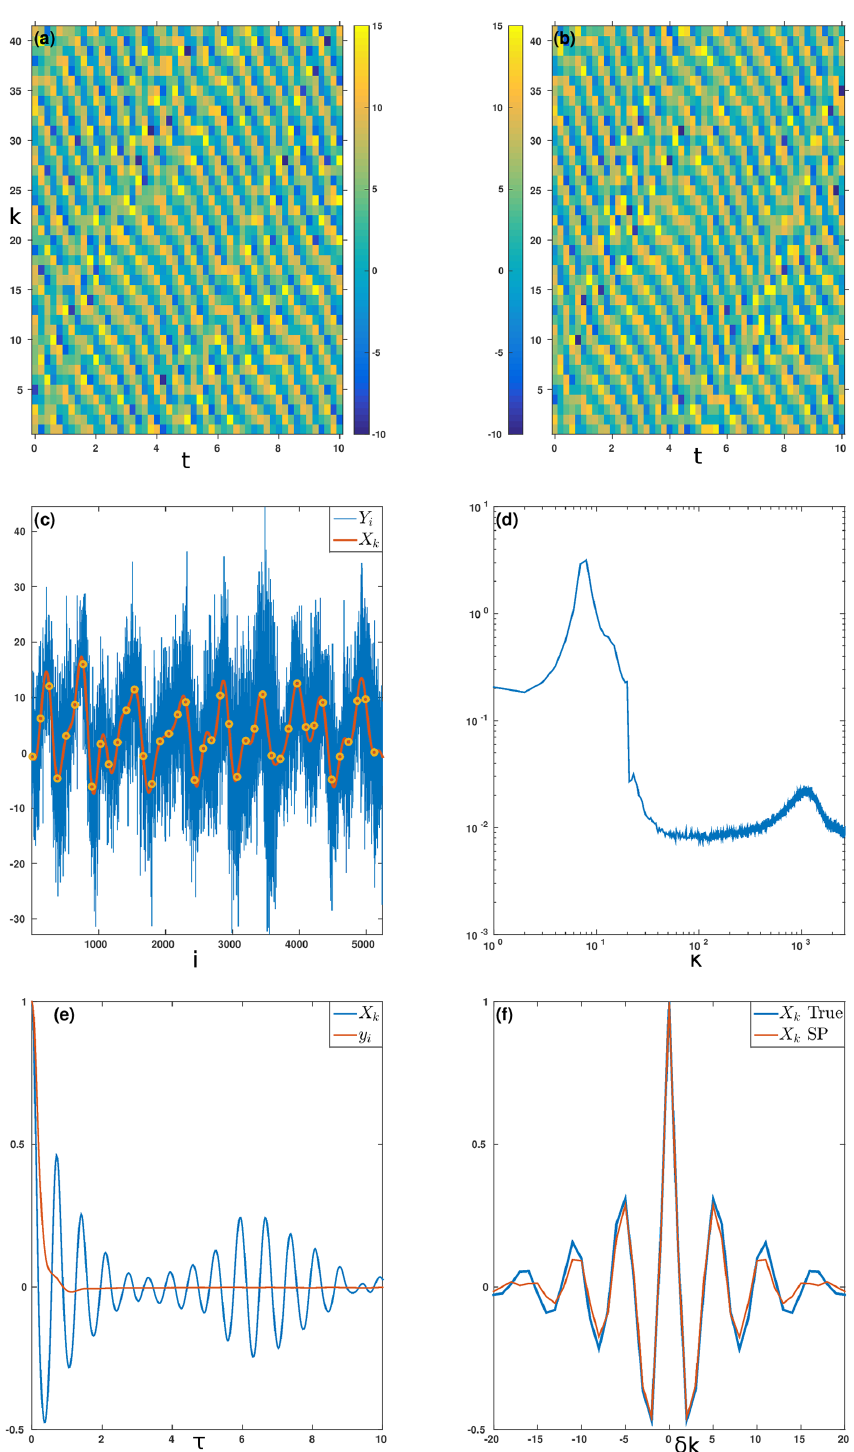
Figure 1. Climatological statistics in regime I. (a) Time series of the X k variables. (b) Time series of the X k variables from the SP approx- imation. (c) A snapshot showing Y i (blue), the large scale part of Y i defined by projection onto the first 41 discrete Fourier modes (red), and the X k variables (yellow circles). (d) Time-averaged energy spectrum | ˆ Y κ | 2 where ˆ Y κ is the discrete Fourier coefficient of Y i with wave number κ . (e) Time-lagged autocorrelation functions for X k (blue) and the small scale part of Y i (red), defined by projecting out the first 41 Fourier modes. (f) Space-lagged autocorrelation functions for X k from the true dynamics (blue) and the SP approximation